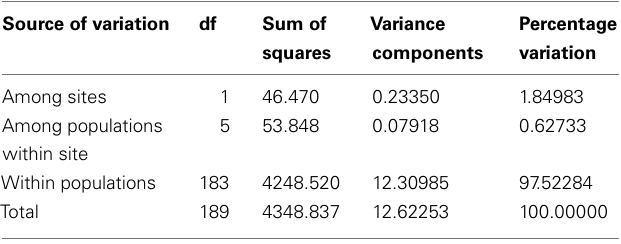
Table 4 | Analysis of molecular variance (AMOVA) averaged across 84